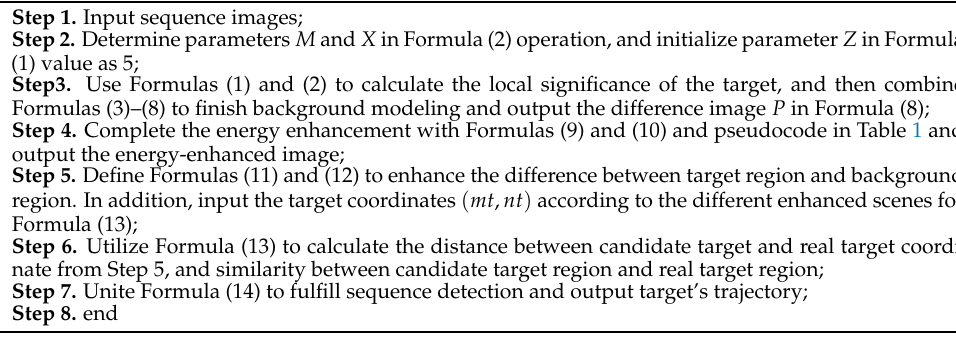
Table 2. Pseudocode of the overall flow of the